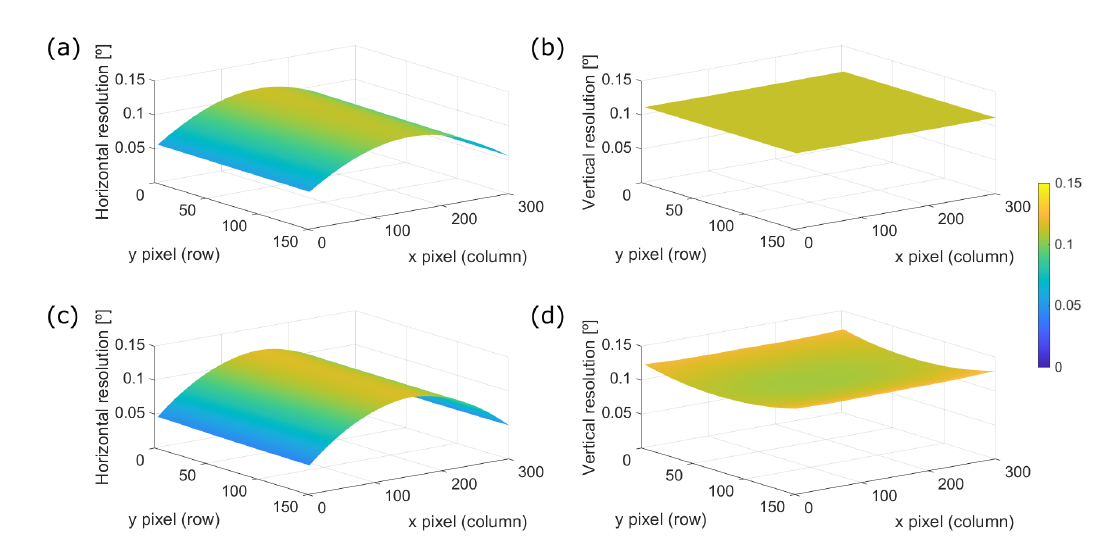
Figure 12. Comparison of respectively both horizontal and vertical angular resolution variations across the whole FOV of the 30 × 20 ◦ FOV prototype. ( a , b ) Sinusoidal dynamics for the fast scanning axis. ( c , d ) Results of the mapping function Map